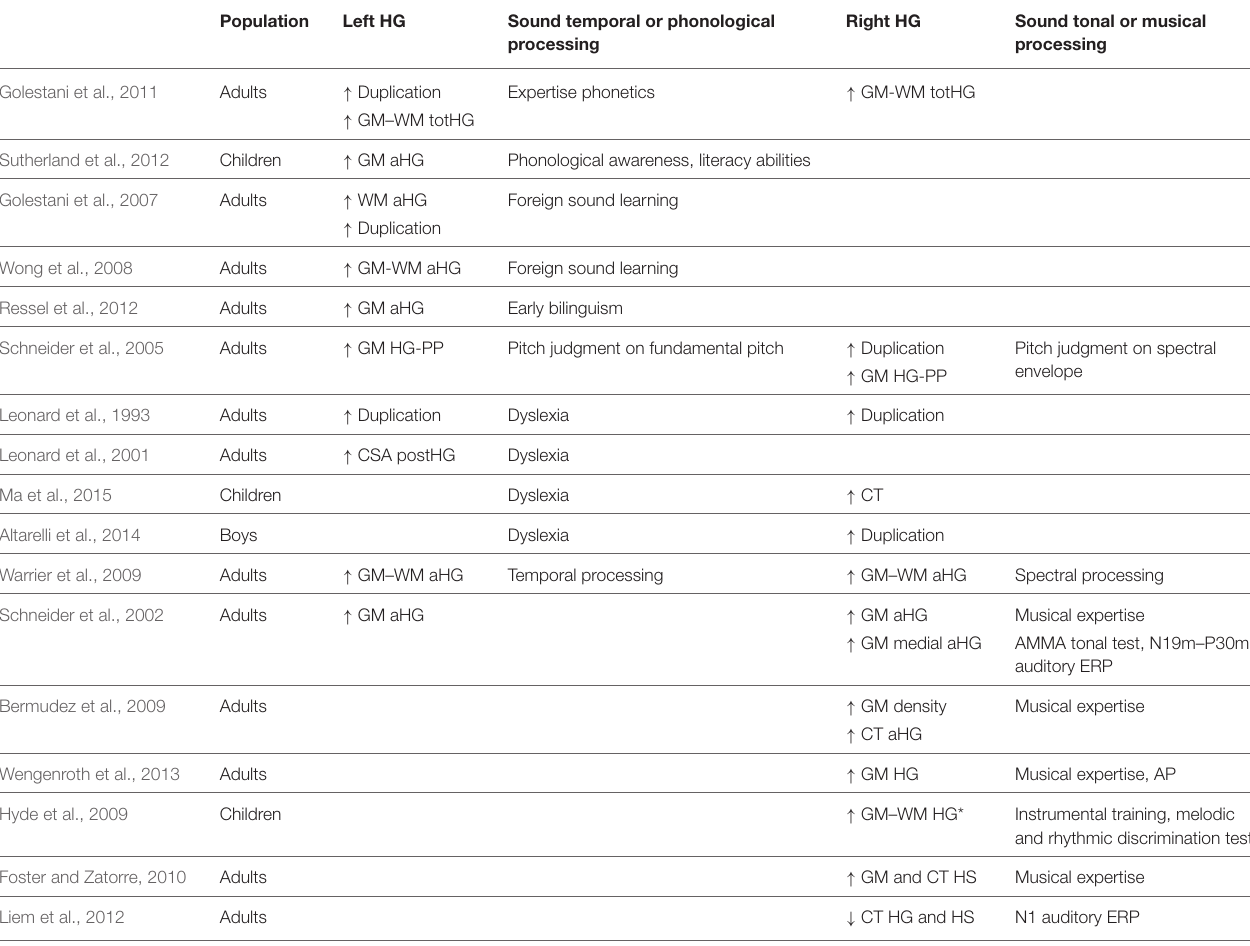
TABLE 1 | Meta-analysis of reports on HG structure changes related to phonology, music, sound processing, or